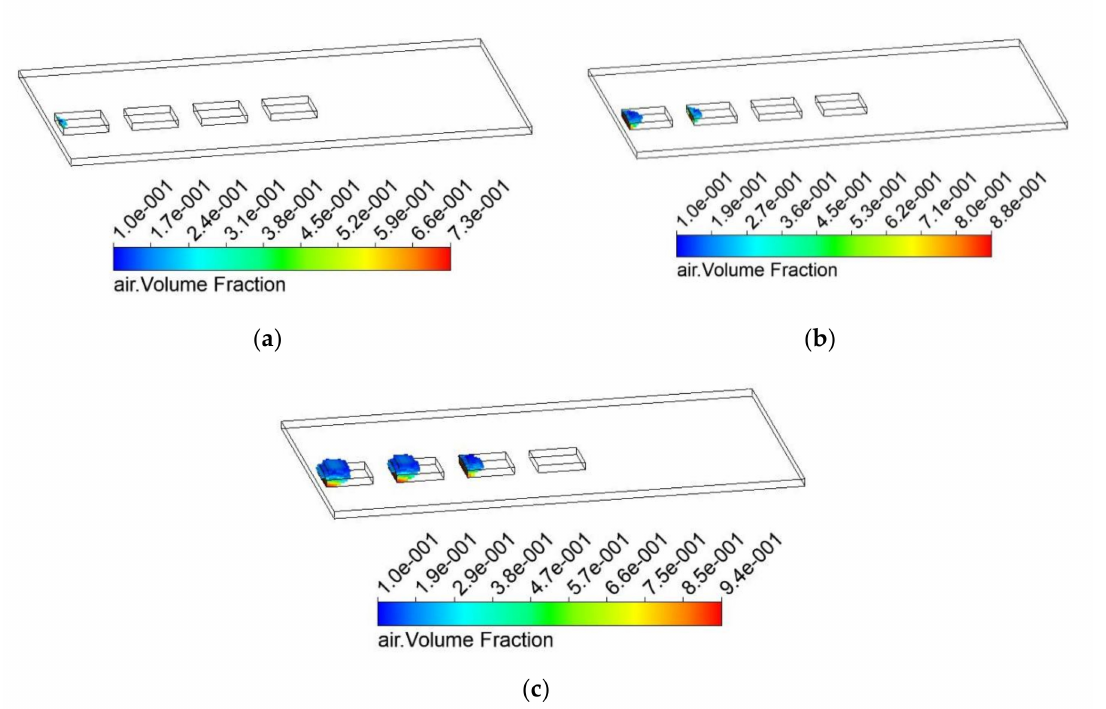
Figure 21. The air volume fraction is generated by a partial texturing configuration with dimples side 50 µ m and gap 8 µ m, sliding velocity 10 m / s. Set A of the cavitation coe ffi cients. Only the portions of the mesh where the volume fraction of air is greater than 10% are highlighted. ( a ) Saturation pressure